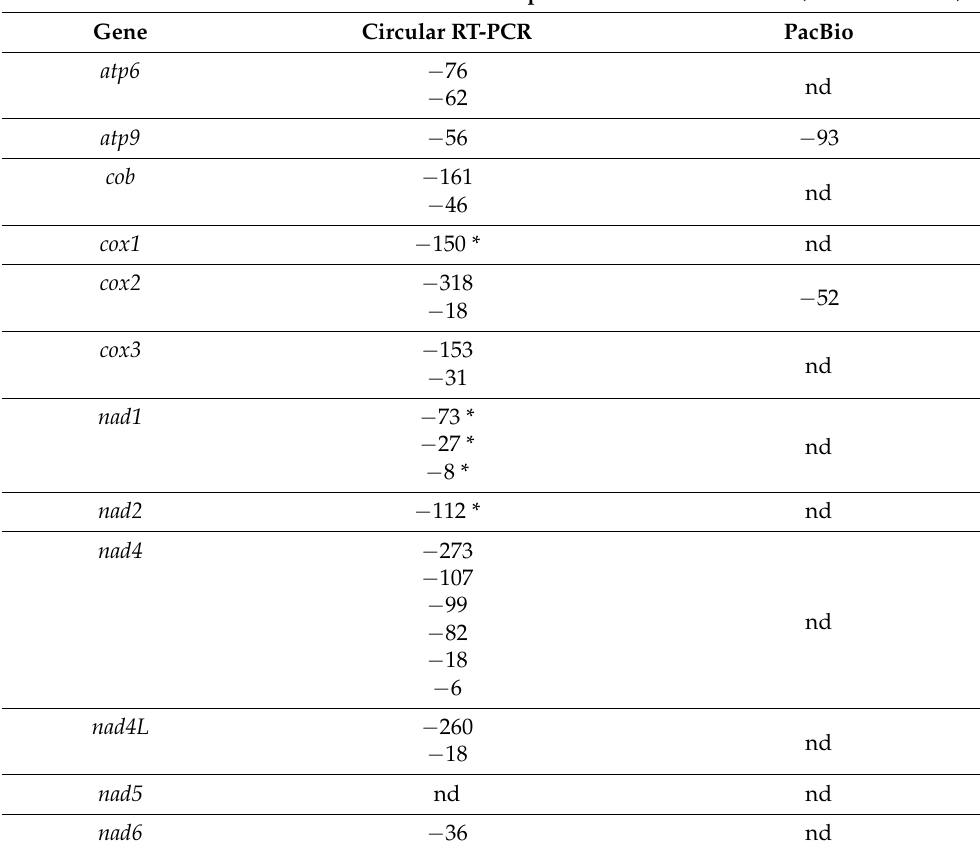
Table 3. Site of 5 (cid:48) UTR terminus upstream from start codon (in nucleotides) in Chara vulgaris mitochondria, nd = no data. * 5 (cid:48) UTR termini detected in this study occur downstream of the start codons found in archived chondriomes. The distances presented in this table are marked from the next available AUG start